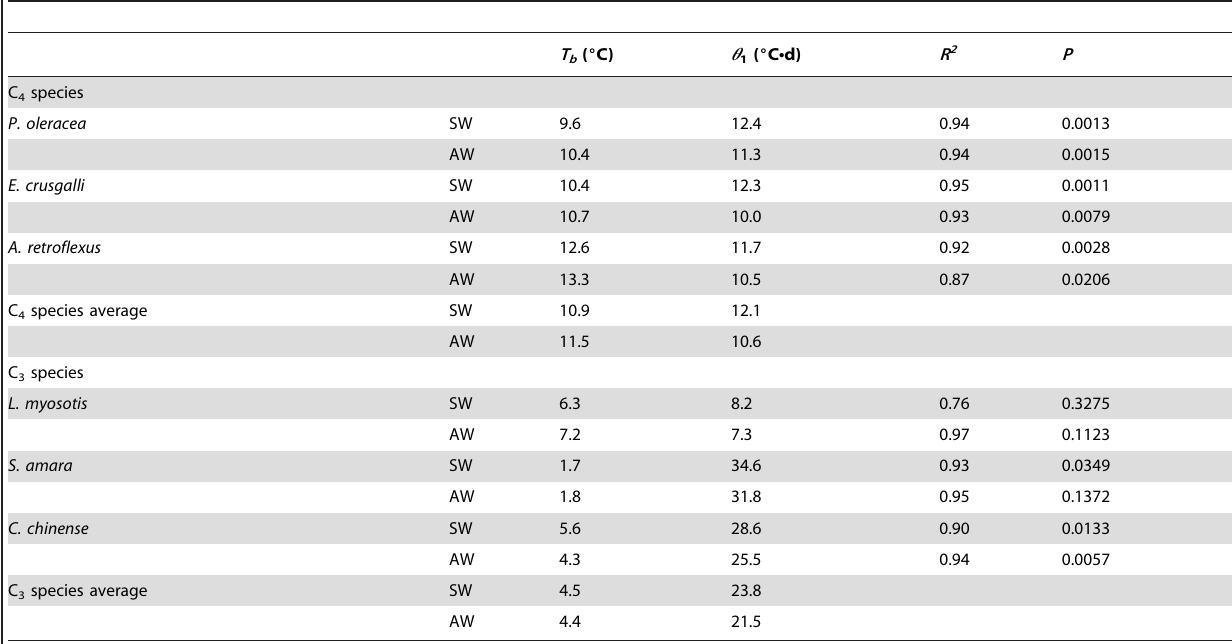
Table 3. Thermal time model parameter estimates ( T b , minimum temperature; h 1 , thermal time constant) for C 4 and C 3 species under the symmetric warming (SW) and asymmetric warming (AW) alternating temperature